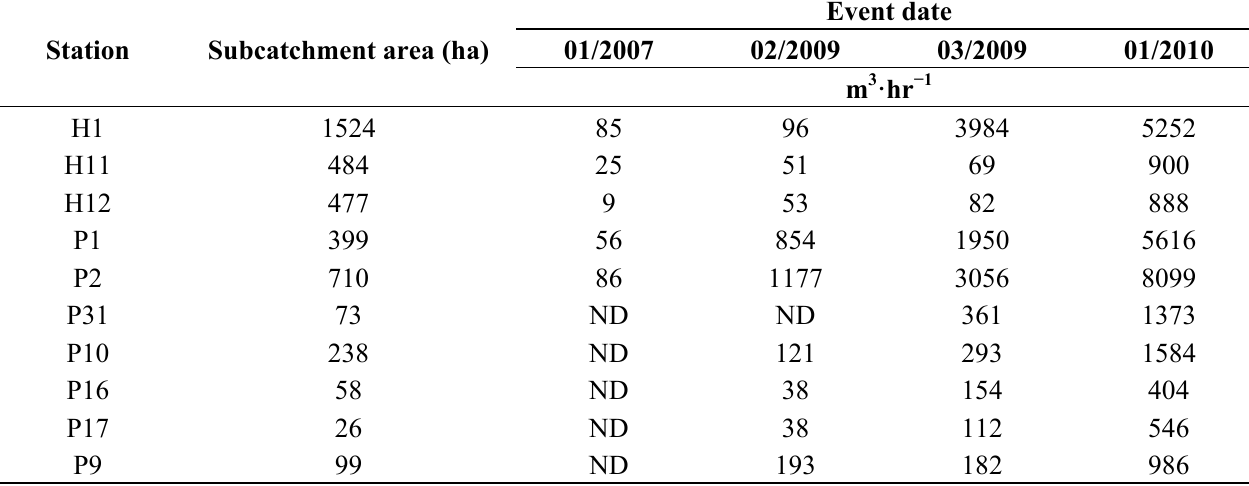
Table 1. Measured discharge values at the 10 sampling stations along the Hermon Stream and its ephemeral tributaries during four hydrological